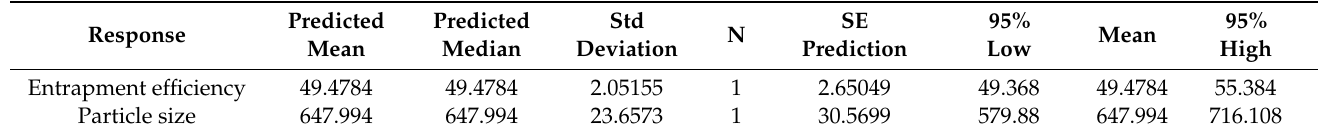
Table 3. Confirmation table of optimized